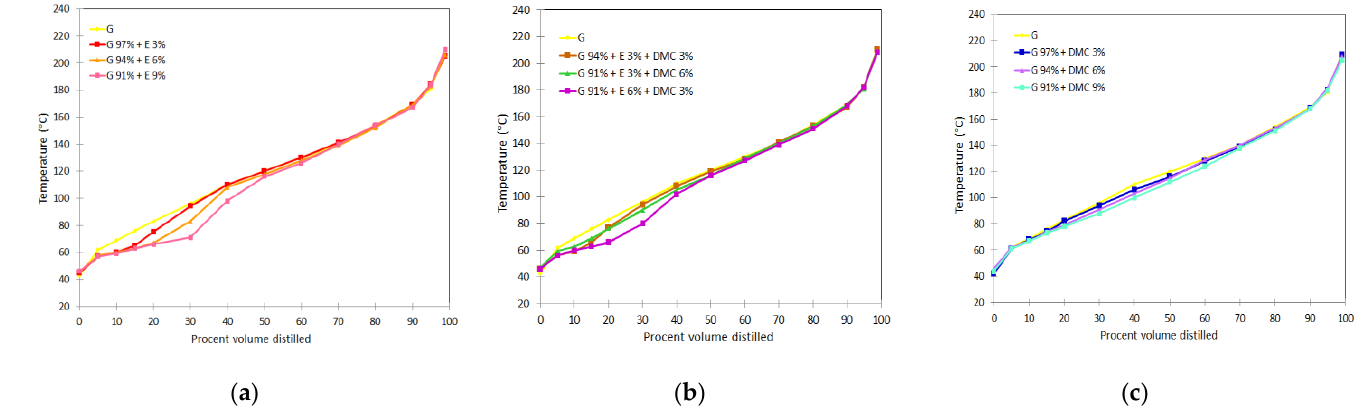
Figure 1. ASTM distillation curves of gasoline and blends: ( a ) blends with ethanol,( b ) blends with DMC,( c ) blends with ethanol and DMC.